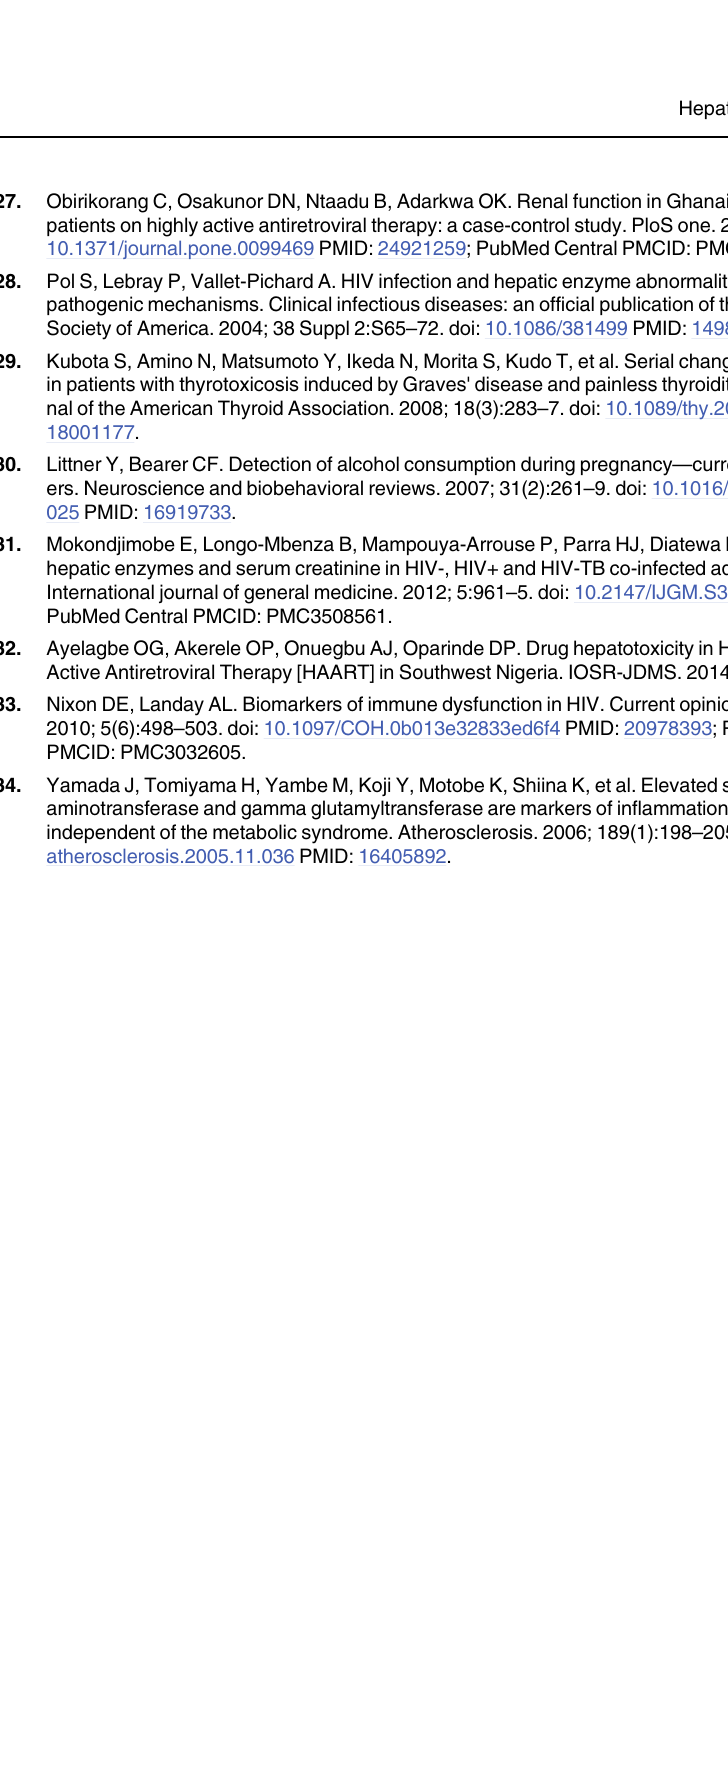
PLOS ONE | DOI:10.1371/journal.pone.0134449 August 6,